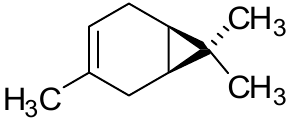
Figure 1. Structural formula of δ -3-carene, the major constituent (78.8%) of M. urundeuva essential